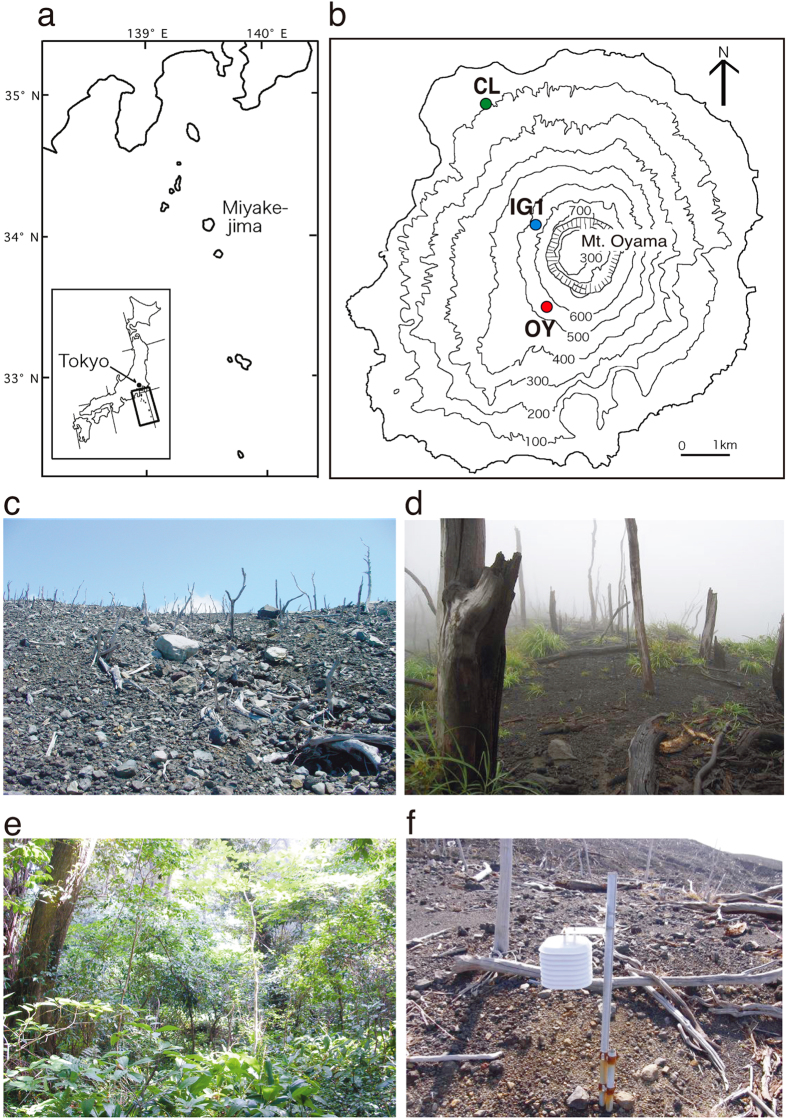
Map of the study site, locations and photographs of sampling sites.(a) Map showing the location of Miyake-jima on the western rim of the Pacific Ocean. (b) Three study sites on the island. Colour plots show each site (red, OY; blue, IG1; green, CL). (c–e) Photographs of each site (c, site OY in 2005; d, site IG1 in 2009; e, site CL in 2005). (f) SO2 data logger. The map was created using Adobe Illustlater CS6.